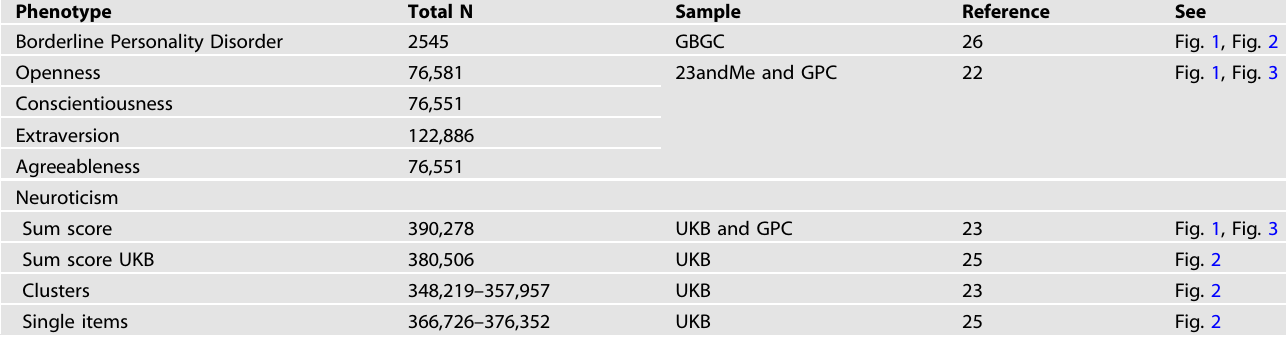
Table 1. Overview of GWAS summary statistics